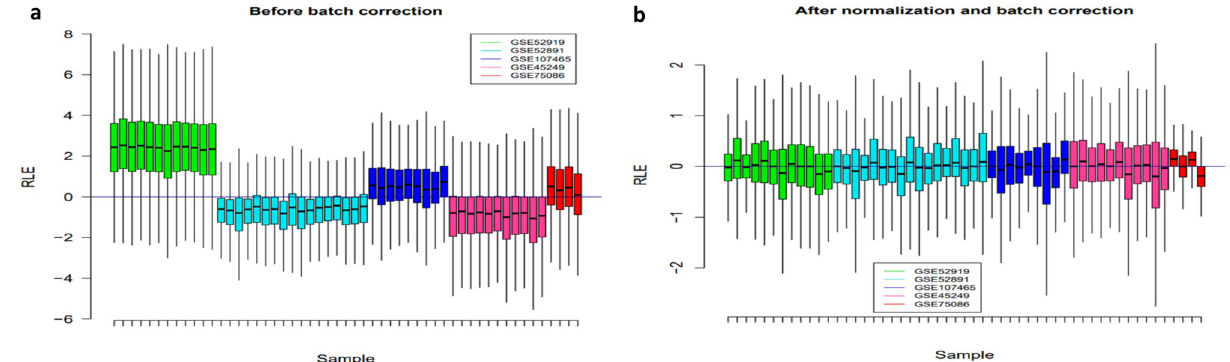
Figure 1. Boxplot for the RLE values. The relative log expression (RLE) box plot of AML sample arrays before ( a ) and after ( b ) batch correction. RLE distribution centered on zero demonstrates almost elimination of unwanted variation. The plot was generated using R language program version 4.0.5 (https:// www.R- proje ct. org/) 57 hood patients (53 sample arrays). (2) Analysis of arrays from patients’ samples (38 sample arrays). (3) Analysis of adult patients (21 sample arrays). Using LIMMA approach and considering the cut-off criteria of P value < 0.05 and |fold change|> 1.5 (Fig. 3), a total of 64, 73 and 143 DEGs were found in chemo-resistant group compared to sensitive group for each mentioned analysis, respectively (Fig. 4). The top significantly up- or down-regulated genes in the first meta-analysis were shown in Fig. 3.